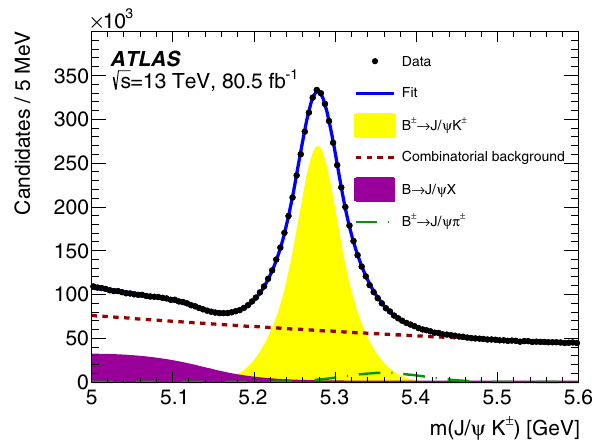
Fig. 1 The invariant mass distribution for selected B ± → J /ψ K ± candidates. Data are shown as points, and the overall result of the fit is given by the blue curve. The contributions from the combinatorial background component are indicated by the red dotted line, partially reconstructed b -hadron decays by the purple shaded area, and decays of B ± → J /ψπ ± , where the pion is misassigned as a kaon, by the green dashed